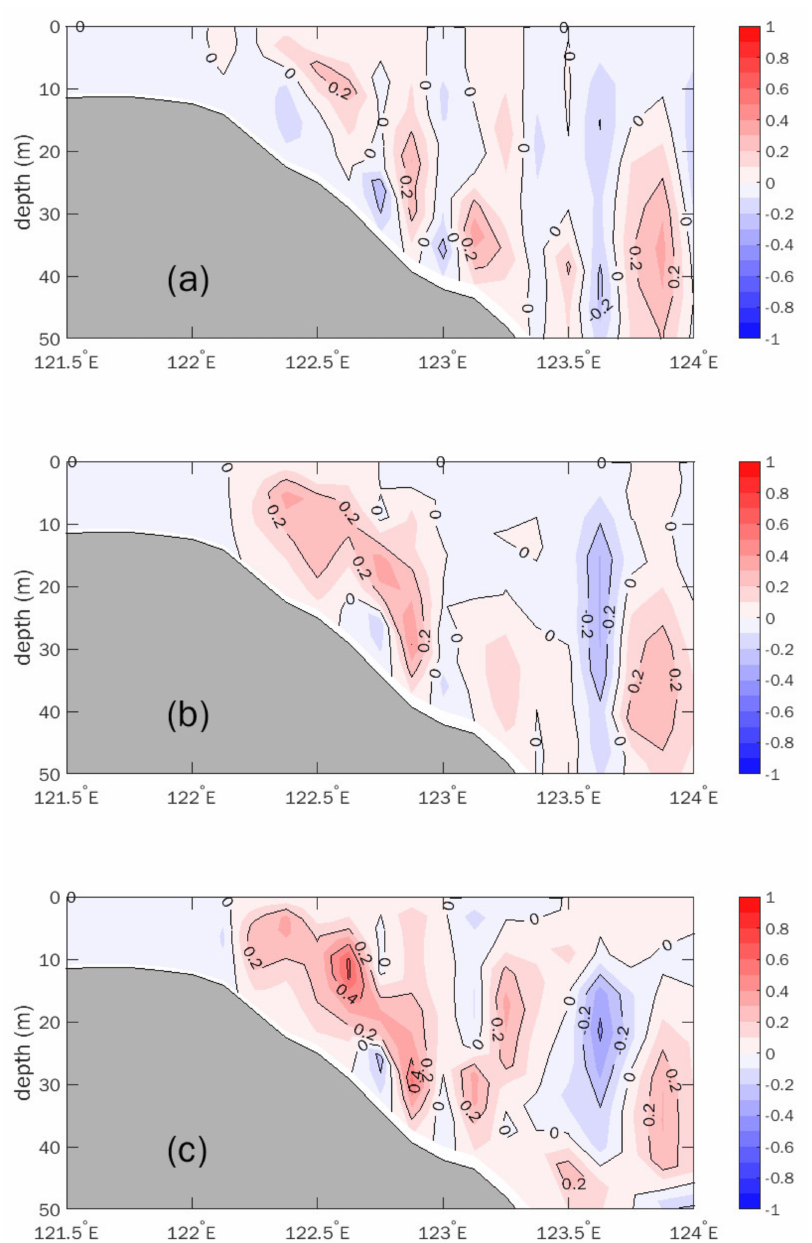
Figure 12. The simulated magnitude of vertical velocity along 33.5 ◦ N section in ( a ) Exp.nw, ( b ) Exp.cw, and ( c ) Exp.curl. Positive and negative values refer to upward and downward cur- rent, respectively. Vertical velocity is magnified 1000